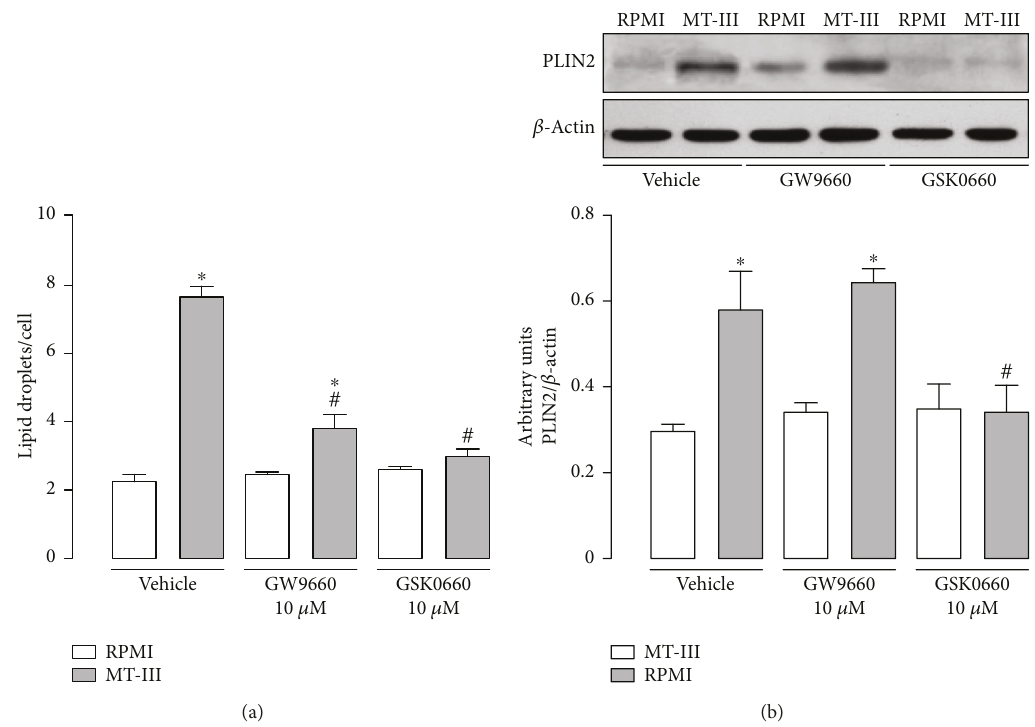
Figure 1: Both PPAR- γ and PPAR- β / δ are involved in MT-III-induced LD formation in macrophages, but only PPAR- β / δ is required for MT-III-induced PLIN2 protein expression in these cells. Peritoneal macrophages were incubated with GW9662 or GSK0660 (10 μ M) compounds for 1h and then with MT-III (0.4 μ M) for 12h. (a) LDs were quanti fi ed using light microscopy after osmium staining. Each bar represents the mean ± SEM LDs/cell in 50 counted cells. Values represent means ± SEM from 3 – 5 animals. ∗ p < 0 05 compared with control group; # p < 0 05 compared with vehicle-treated MT-III-stimulated cells. (b) Western blotting and densitometric analysis of the band intensities of PLIN2 and β -actin (loading control) in macrophage extracts. The densities (in arbitrary units) were normalized with those of β -actin. Results are expressed as mean ± SEM from three experiments. ∗ p < 0 05 compared with controls. # p < 0 05 compared with vehicle-treated MT-III-stimulated 12 h after incubation of macrophages with MT-III. As seen in Figure 1(a), pretreatment of cells with GW9662 (10 μ M), a PPAR- γ antagonist, caused 74% reduction in the number of LDs in MT-III-stimulated macrophages when compared with vehicle-treated macrophages stimulated with MT-III.